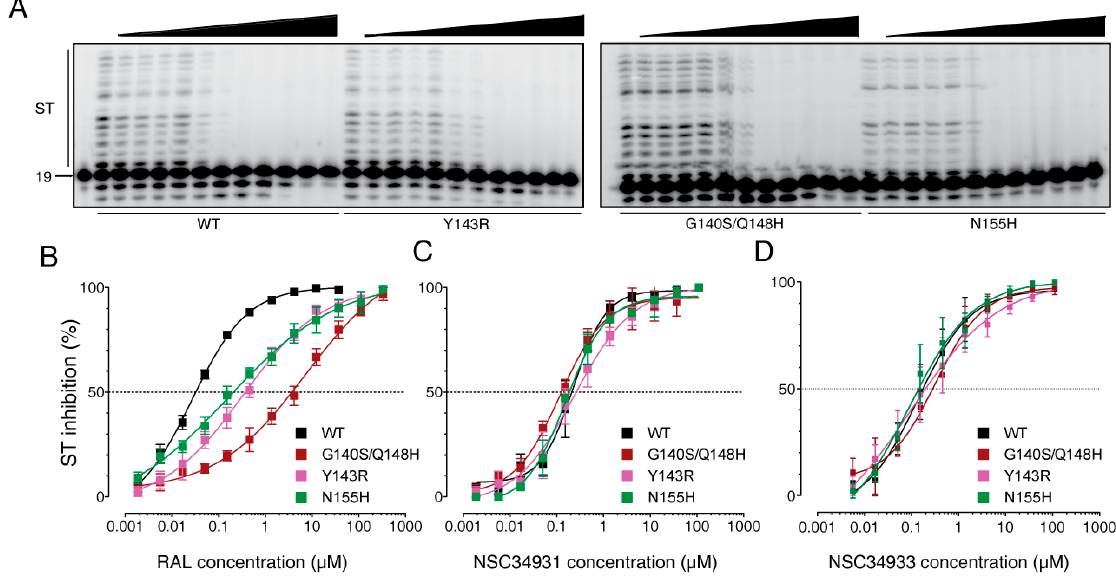
Figure 2. Activity of stilbene disulfonic acid derivatives against the ST activity of clinical RAL-resistant IN mutants. ( A ) Representative PAGE images showing NSC34931 inhibition of ST in the context of WT, Y143R, G140S / Q148H, and N155H RAL-resistant HIV-1 mutant integrases. ( B – D ) Quantitative analysis of the inhibition of ST by RAL, NSC34931, and NSC34933 derived from the densitometric analysis of gel-based experiments (including gels presented in panel A). Fitting curves and error bars represent the mean ± SD from 10, 6, and 7 independent experiments for RAL, NSC34931, and NSC34933,